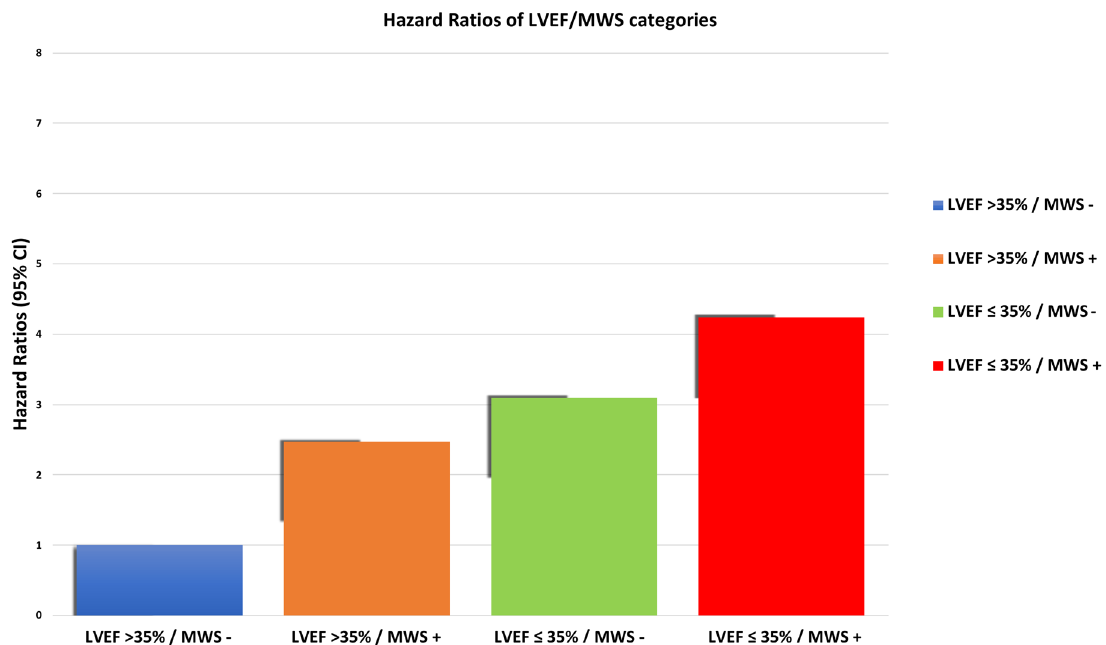
Figure 4. Hazard ratios provided by each of four DCM phenotypes defined using the combined presence or absence of mid-wall striae (MWS) fibrosis and LVEF ≤